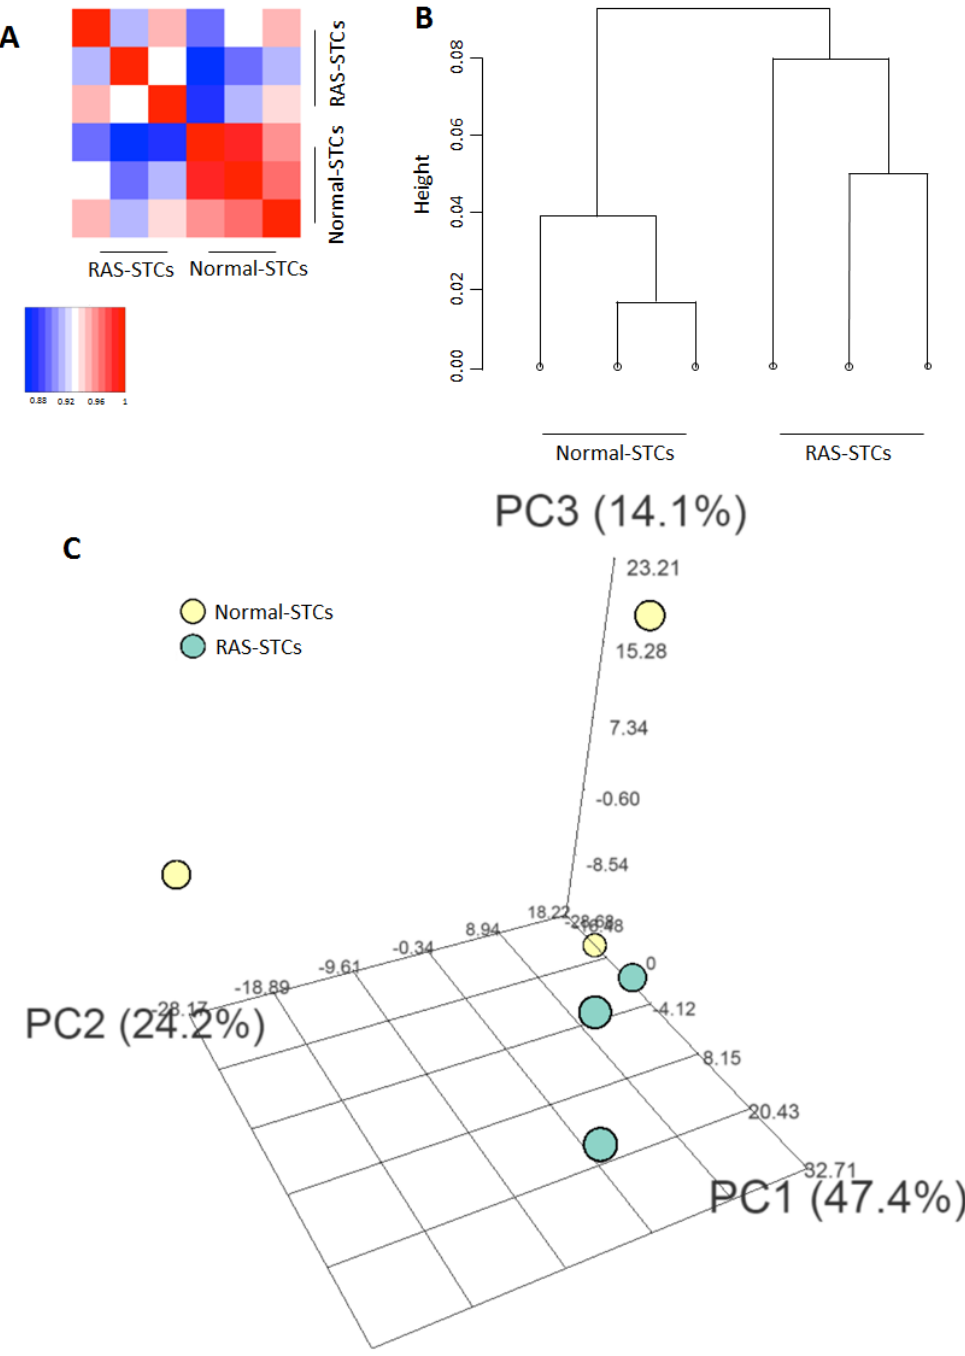
Figure 2. mRNAseq analysis. ( A ) Correlation between messenger RNA sequencing data derived from scattered tubular-like cells (STCs), showing well-defined Normal and renal artery stenosis (RAS) groups. ( B ) Hierarchical clustering showing the pattern of expression of Normal- and RAS-STCs ( n = 3 each). ( C ) Three-dimensional plots of the first three components of STCs showing complete separation between samples from Normal and RAS pigs ( n = 3 each).